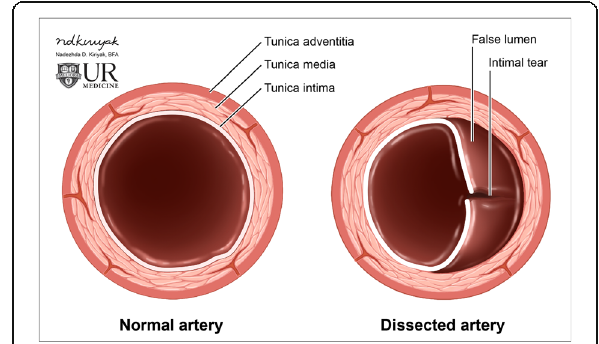
Fig. 11 Arterial dissection. Illustration of the normal layers of an arterial vessel (left). Dissection occurs when a tear in the intimal layer allows blood to collect between the tunica intima and tunica media, creating a false lumen (right)